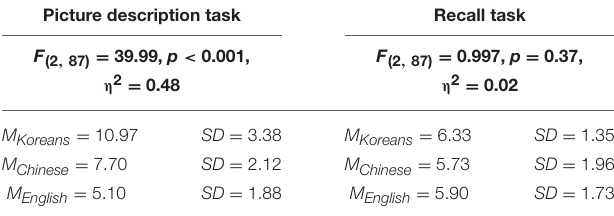
TABLE 2 | Summary of